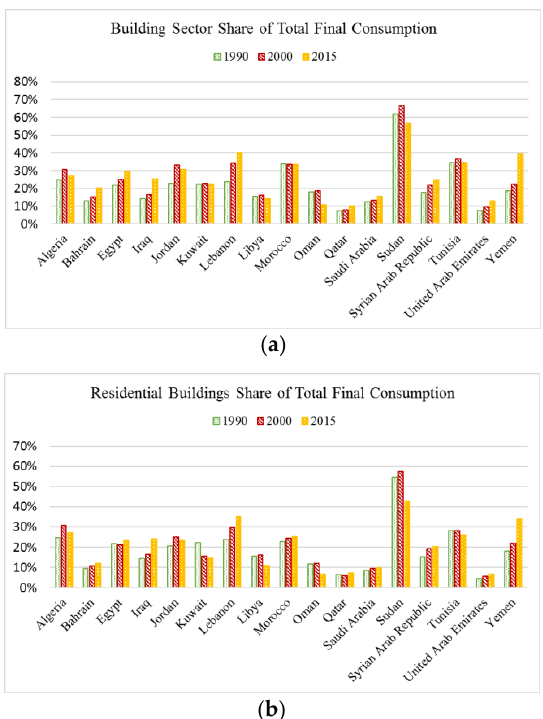
Figure 11. Share of ( a ) entire building sector and ( b ) the residential buildings in total final energy consumption in most countries within the Arab region for 1990, 2000, and 2015.